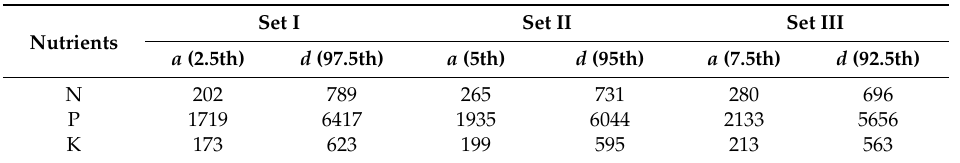
Table 6. Envelope coe ffi cients relating fruit yield to the maximum accumulation ( a ) and maximum dilution ( d ) of N, P and K in the shoot dry matter of all watermelon. Constants a and d were calculated by excluding the upper and lower 2.5th (set I), 5.0th (set II), and 7.5th (set III) percentiles of all nutrient e ffi ciency data of the combined dataset.